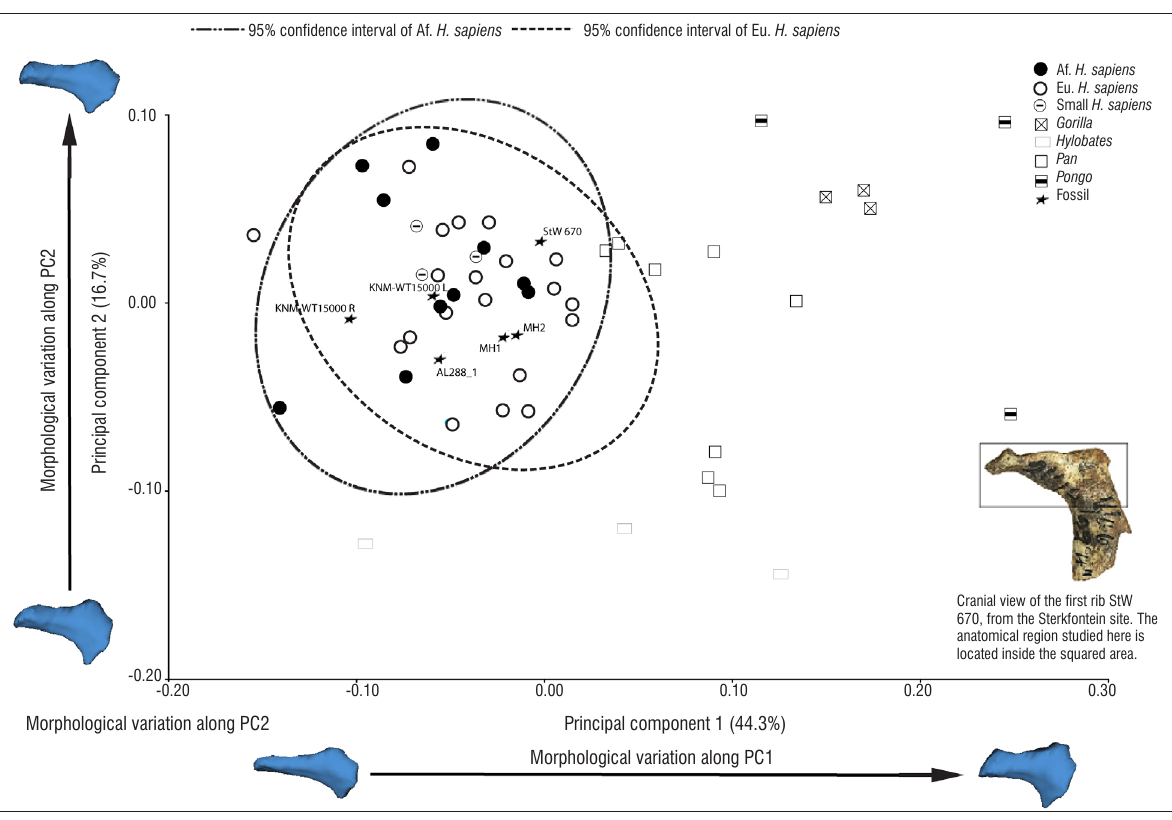
Figure 6: Principal component (PC)-shape analysis of first ribs of all specimens. Scatterplot of PC1 (44.3% of total variance) and PC2 (16.7% of total variance), and warped 3D models of proximal parts of first ribs in axial view. Note that fossil specimens (stars) are within the 95% confidence ellipse of European (Eu) and African (Af) Homo